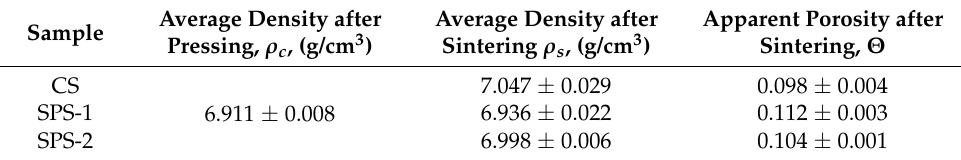
Table 4. The average density and apparent porosity of samples after pressing and sintering.